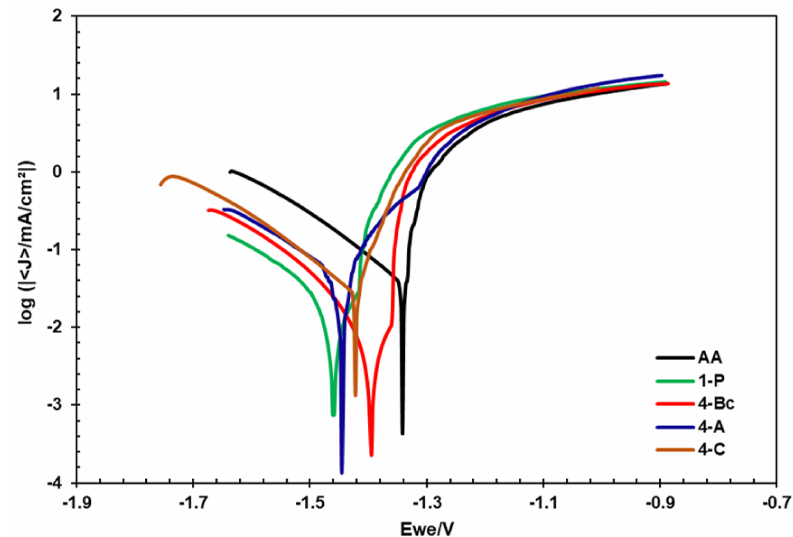
Figure 8. Linear potentiodynamic polarization curves of the ZK30 alloy before and after ECAP processing.